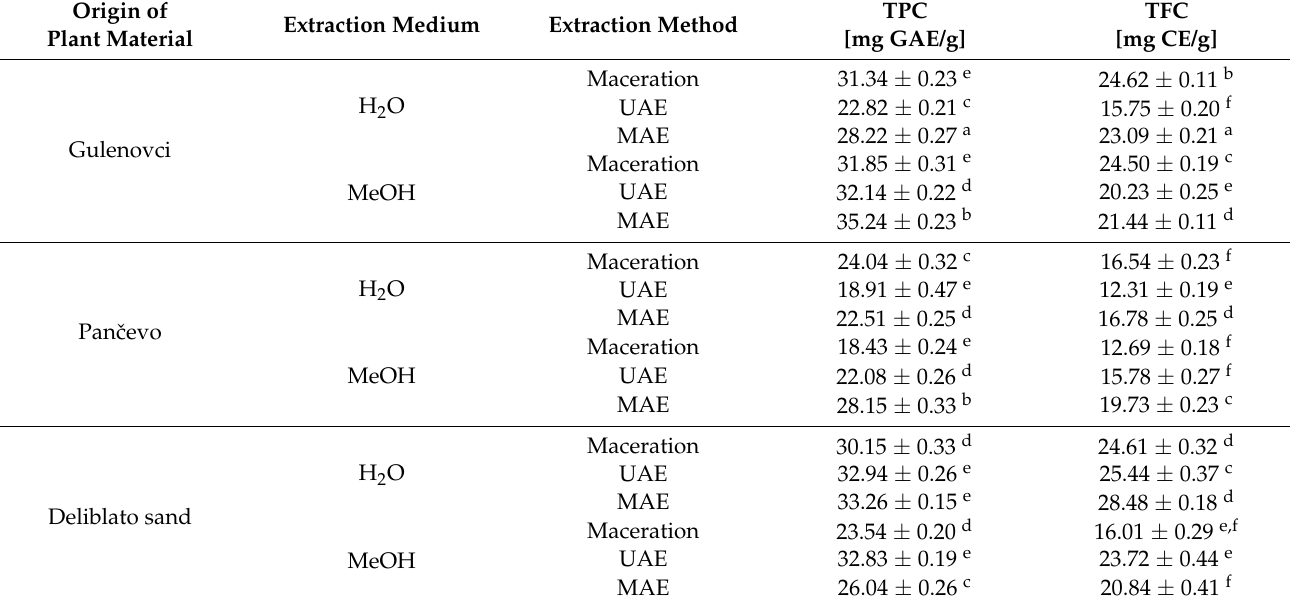
Table 1. Total polyphenol (TPC) and total flavonoid content (TFC) of Paeonia tenuifolia L. extracts obtained by different extraction methods and extraction